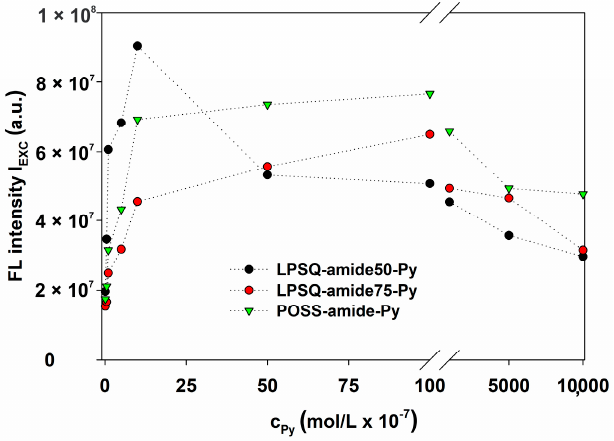
Figure 12. Changes in fluorescence excimer intensity as a function of pyrene moieties concentration ( λ ex = 430 nm).